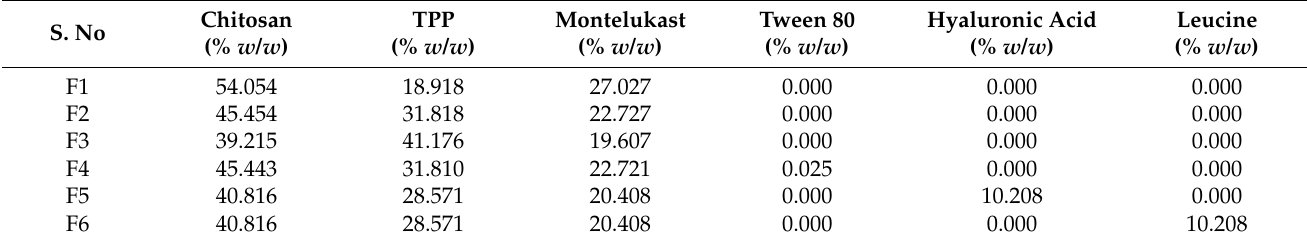
Table 1. Formulation of montelukast-loaded chitosan nanoparticles.